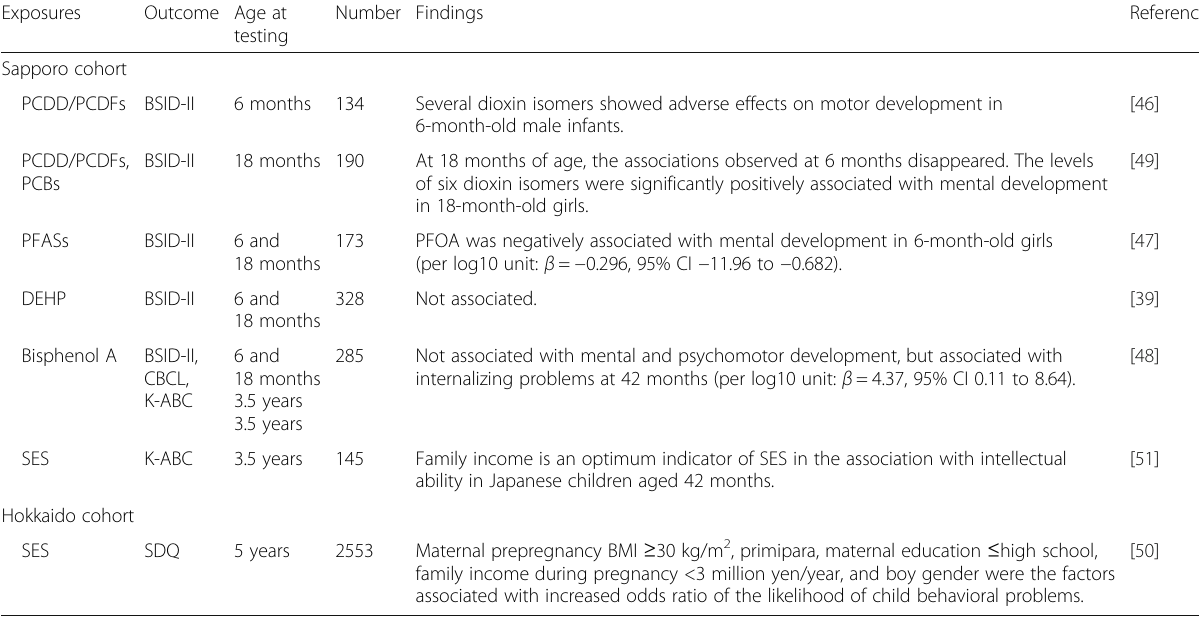
Table 9 Findings from the Sapporo and Hokkaido cohorts on the relationship between exposures and neurodevelopment